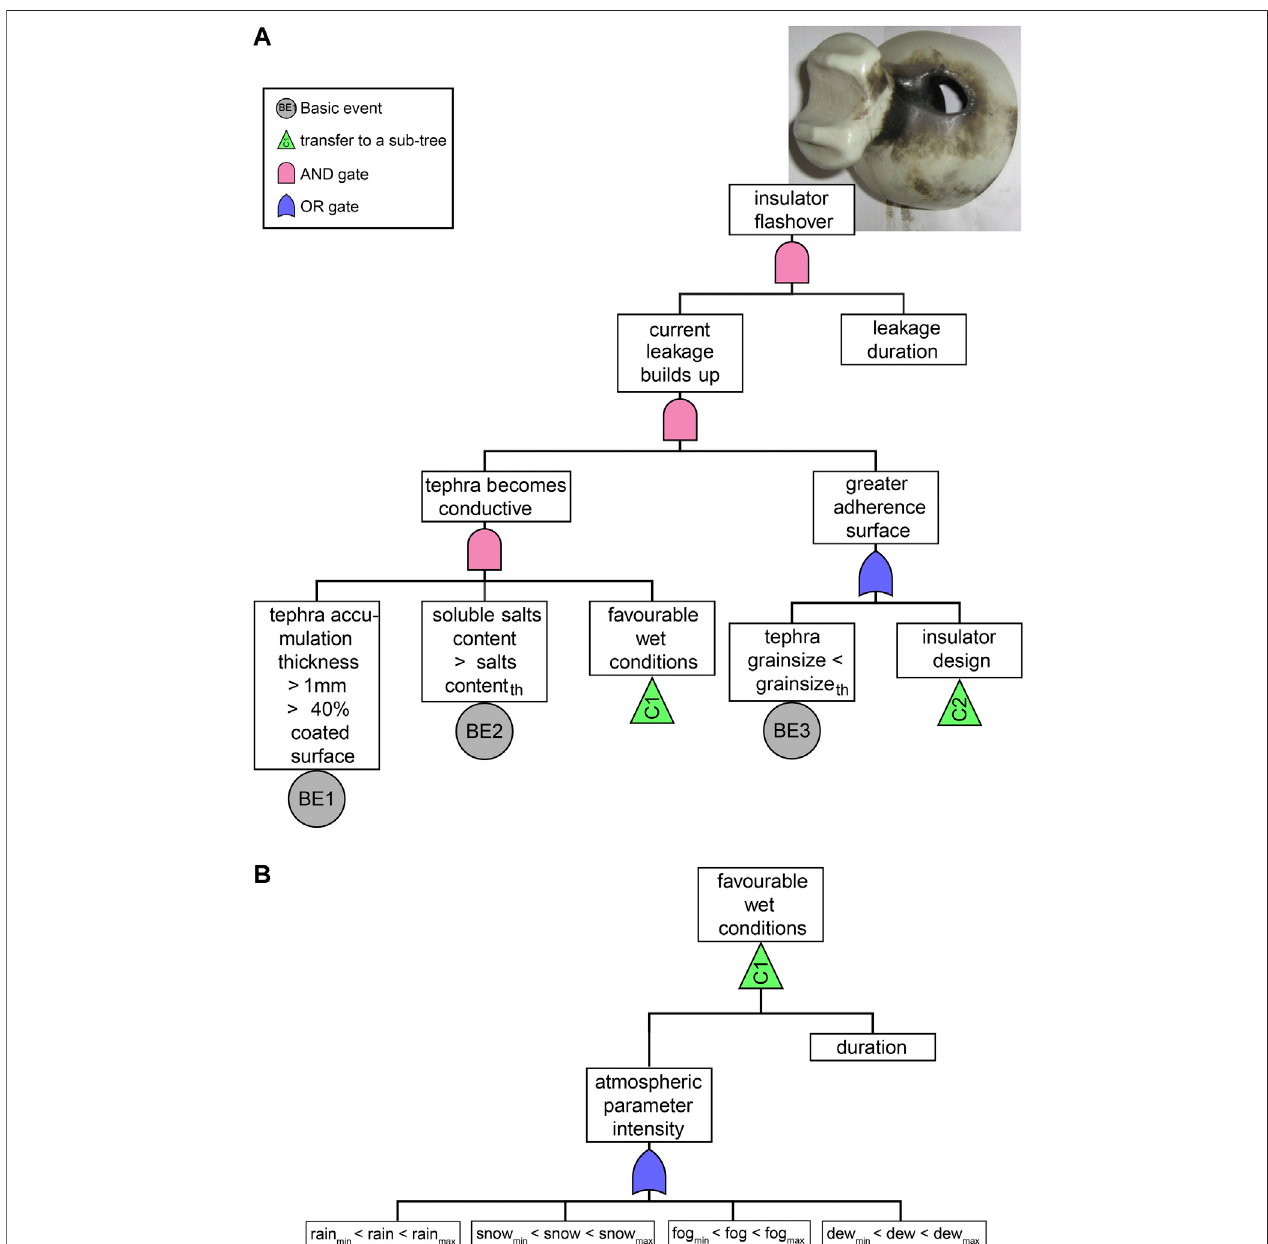
FIGURE 8 | First order of impact: electrical insulator fl ashover described by a main fault tree (A) including subtrees (green triangles). The subtreeC1 describing the atmospheric favourable conditions is shown in (B) . Content th and grainsize th indicate threshold values that still need to be explored. Photo courtesy: Cooperative of Electricity of